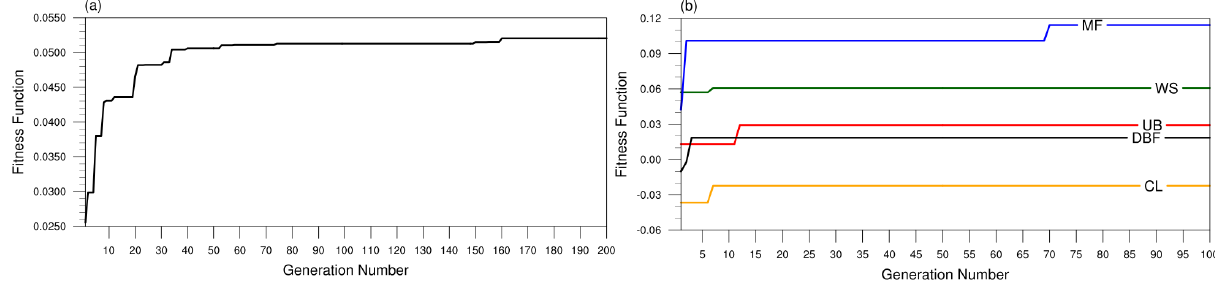
Figure 4. The fitness function for generations during (a) five-snow-parameter optimization (OPT_5) and (b) W max optimization (OPT_W) for DBF (black), MF (blue), WS (green), CL (yellow), and UB (red) LCTs. Table 3. Summary of optimized snow parameters related to snow variables. Minimum (min), default, and maximum (max) are the ranges used in the optimization process. Default is the empirical value used in the Noah LSM. Snow variable Snow parameter